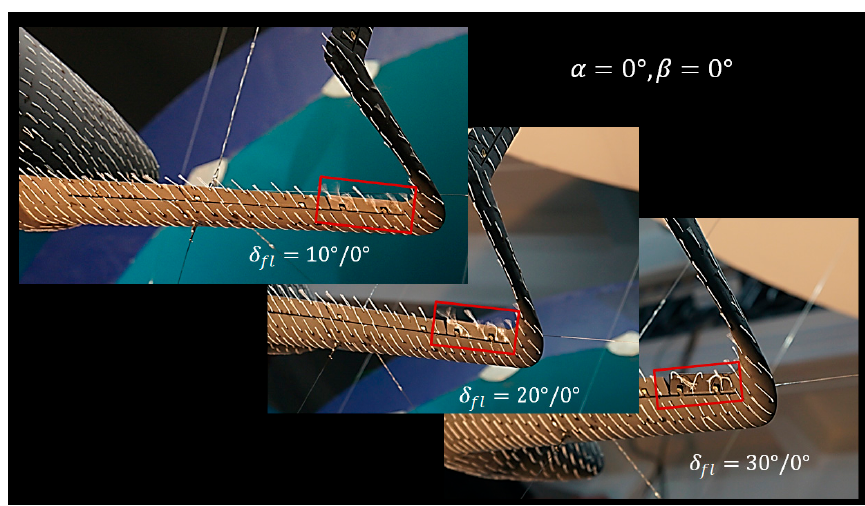
Figure 17 . Lift curve for cruise, take-off, and landing configuration. Data taken from [19].